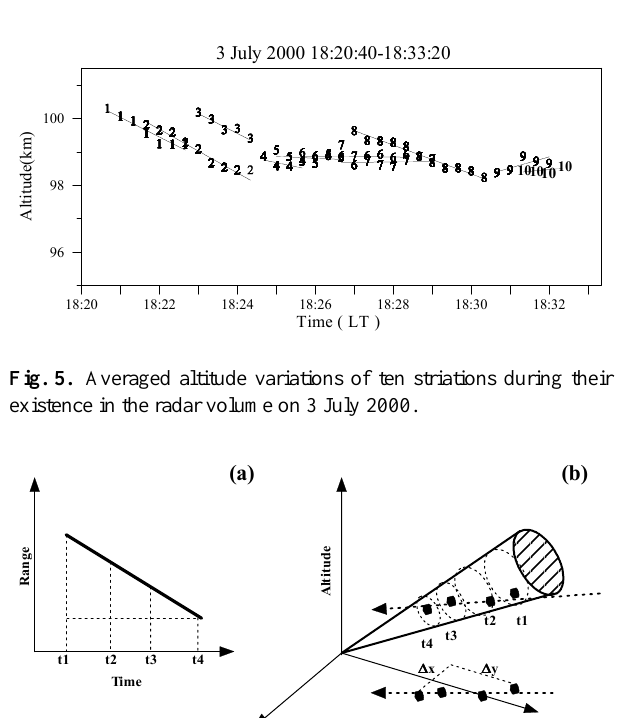
where dx/dt , dy/dt and dz/dt are the velocity projections of the target in the x, y and z direction, respectively. The mean velocity projections in the x, y and z directions of the stria- tions are used for our dx/dt, dy/dt and dz/dt , respectively. Us- ing Eqs. (1) and (2), we find that the elevation and azimuth of the targets lay between 48 ◦ ≤ θ ≤ 53 ◦ , − 15 ◦ ≤ φ ≤ 5 ◦ , re- spectively. By finding θ(ω) and φ(ω) for individual echo patches and mean velocity projections in the x, y and z di- rections of the striation, the range rate is estimated and aver- aged, respectively. In order to qualify this estimate, deduced from the interferometer measurements, we compared these results with the observed range rate, which is obtained from the slope of the striations in RTI plot. Figure 7 presents the corresponding correlation of the range rate deduced directly from the RTI and the one deduced from the interferometer